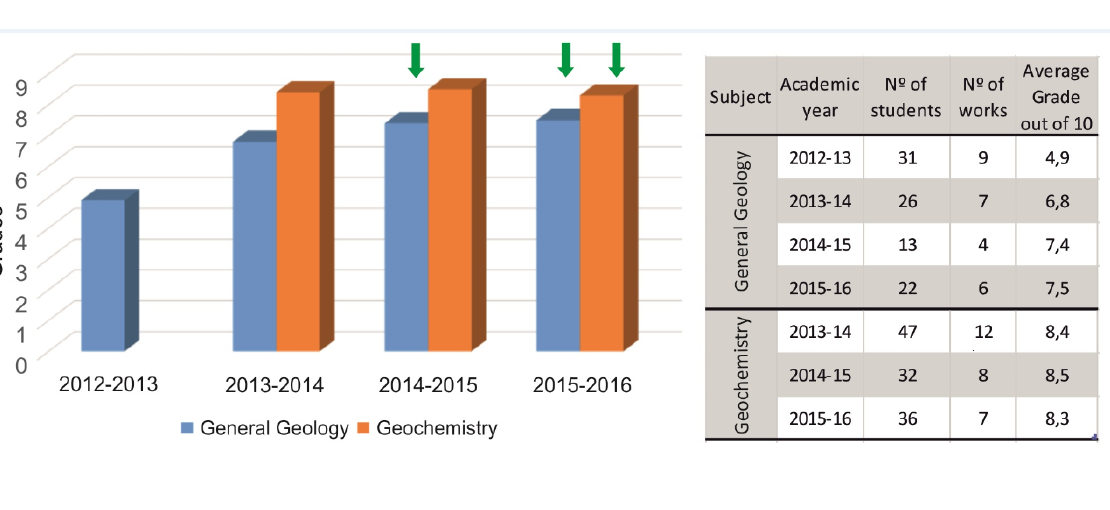
Figure 2. Academic results in General Geology (first-year) and Geochemistry (third-year) before and after the implementation of the innovation project. In the graphic, green arrows pinpoint the years when the innovation project was implemented in each